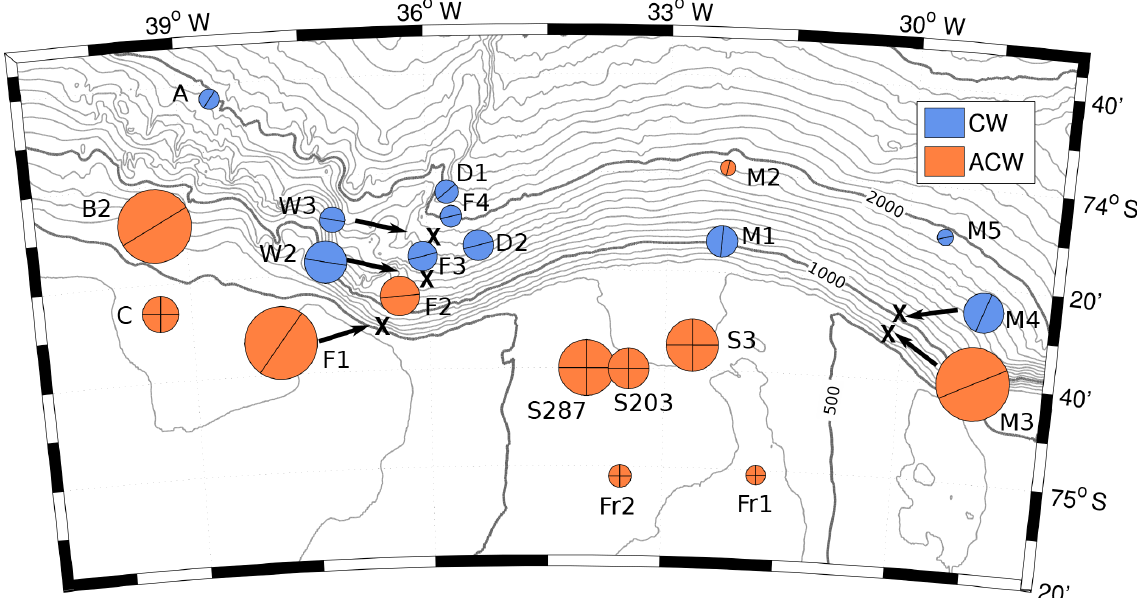
Figure 5. Map showing the maximum depth-averaged, diurnal tidal KE reached in austral summer. The area of the circles is proportional to the square root of the KE. Blue circles indicate a clockwise (CW) rotation of tidal currents at the K 1 frequency, red circles indicate an anticlockwise (ACW) rotation. The line through the circles indicates the orientation of the major axis (i.e. strongest tidal current). Tidal current ellipses with an aspect ratio (semi-minor/semi-major axis) of more than 0.8, i.e. close to circular, are marked with two crossing lines instead of a single line. At the location of mooring S2 with 5 years of measurements, the data for the deployment years 1987 (S287) and 2003 (S203) are presented. Some circles are displaced from their actual mooring locations (marked with “X”) for legibility.